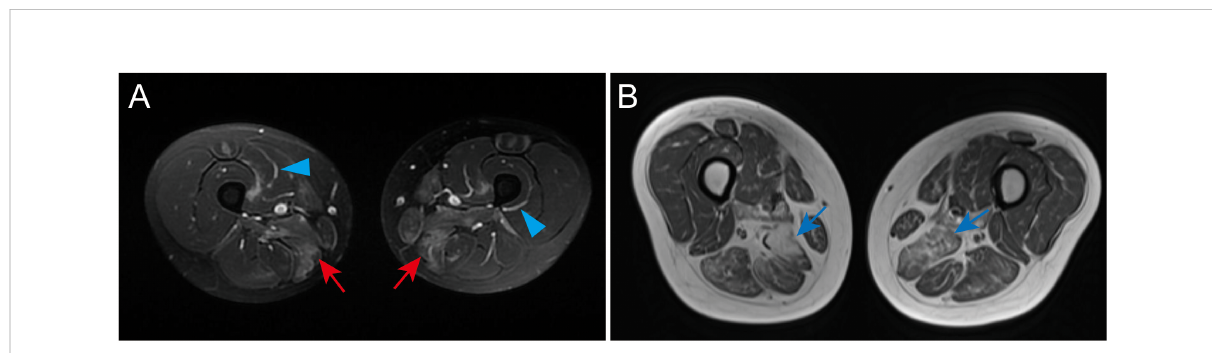
FIGURE 1 Examples of a thigh and lower leg MRI in SRP-IMNM. (A) , a T2-weighted image shows obvious edema in the adductor magnus, gracilis, and sartorius of the thigh (red arrow) and fascial edema (blue arrowhead). (B) , a T1-weighted image reveals evident muscle atrophy and fatty replacement in the posterior muscles of the thigh (blue arrow). These pictures are cited from our previous study